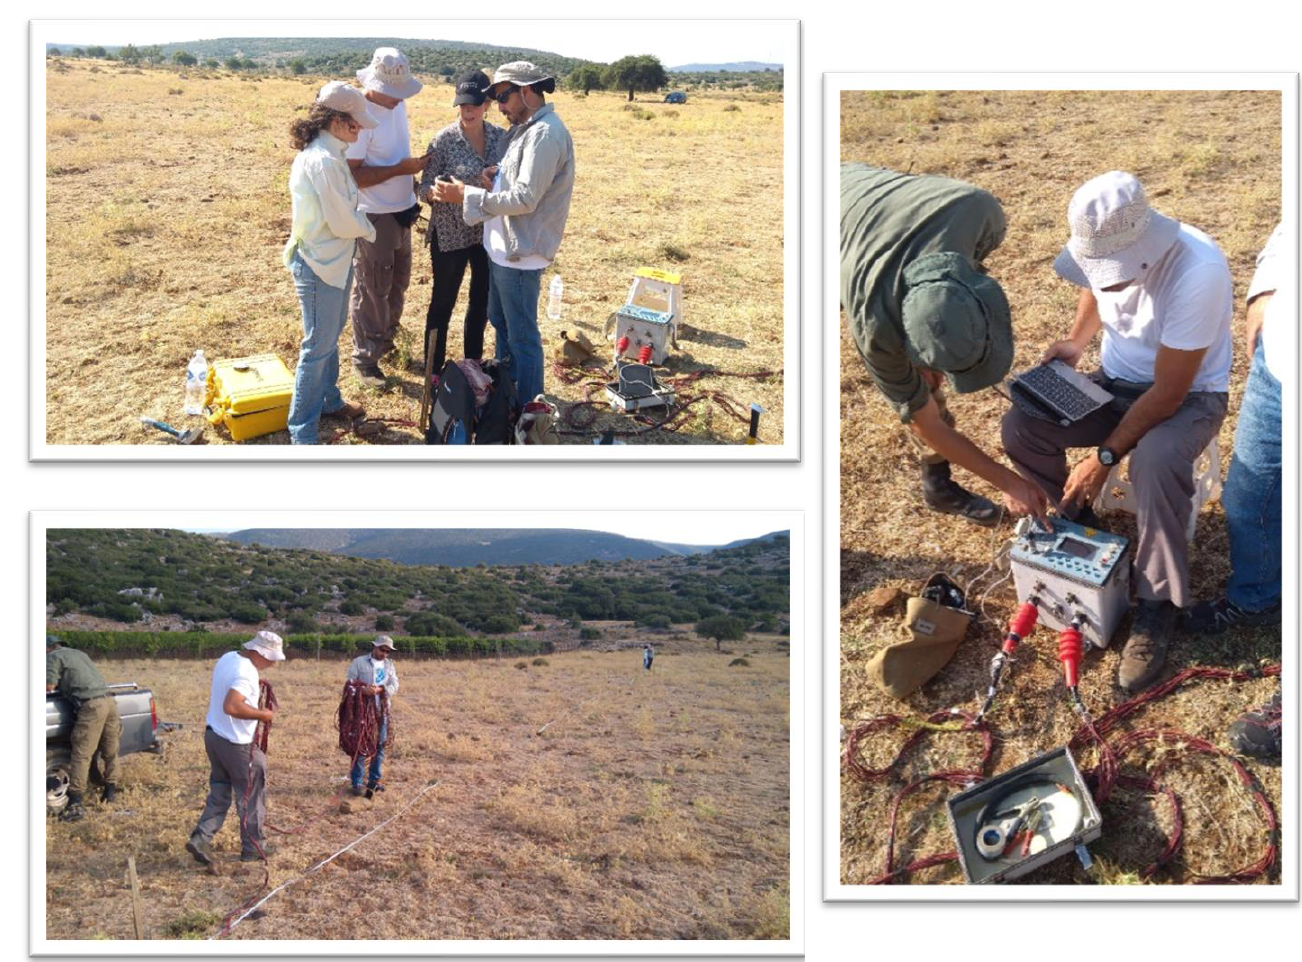
Figure 3. On the site of Meteles plain arranging ERT measurements (© IL). Upper left: four of the co-authors preparing for the ERT measurements in situ, Left: two co-authors lay the cables for ERT, Right: taking a reading in situ.